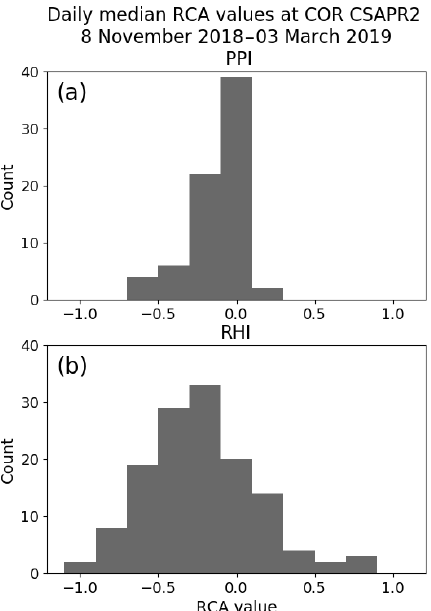
Figure 13. Histogram of daily mean RCA values for COR CSAPR2 between 8 November 2018 and 3 March 2019. The variability in RCA values is demonstrated to fall well within ± 1dB. Additionally the variability in the eRCA technique using the two different scan types is